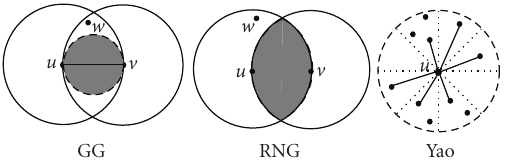
Figure 1: Rules of GG, RNG, and Yao graphs.